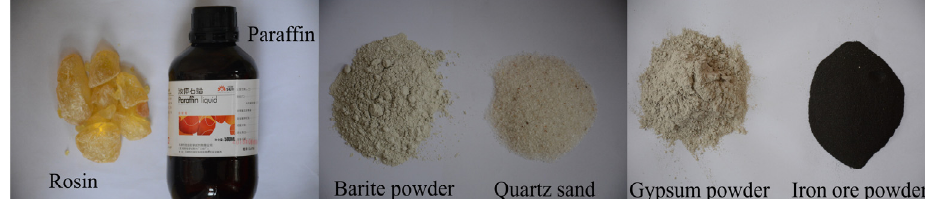
Figure 1. Main compositions of the similar material.